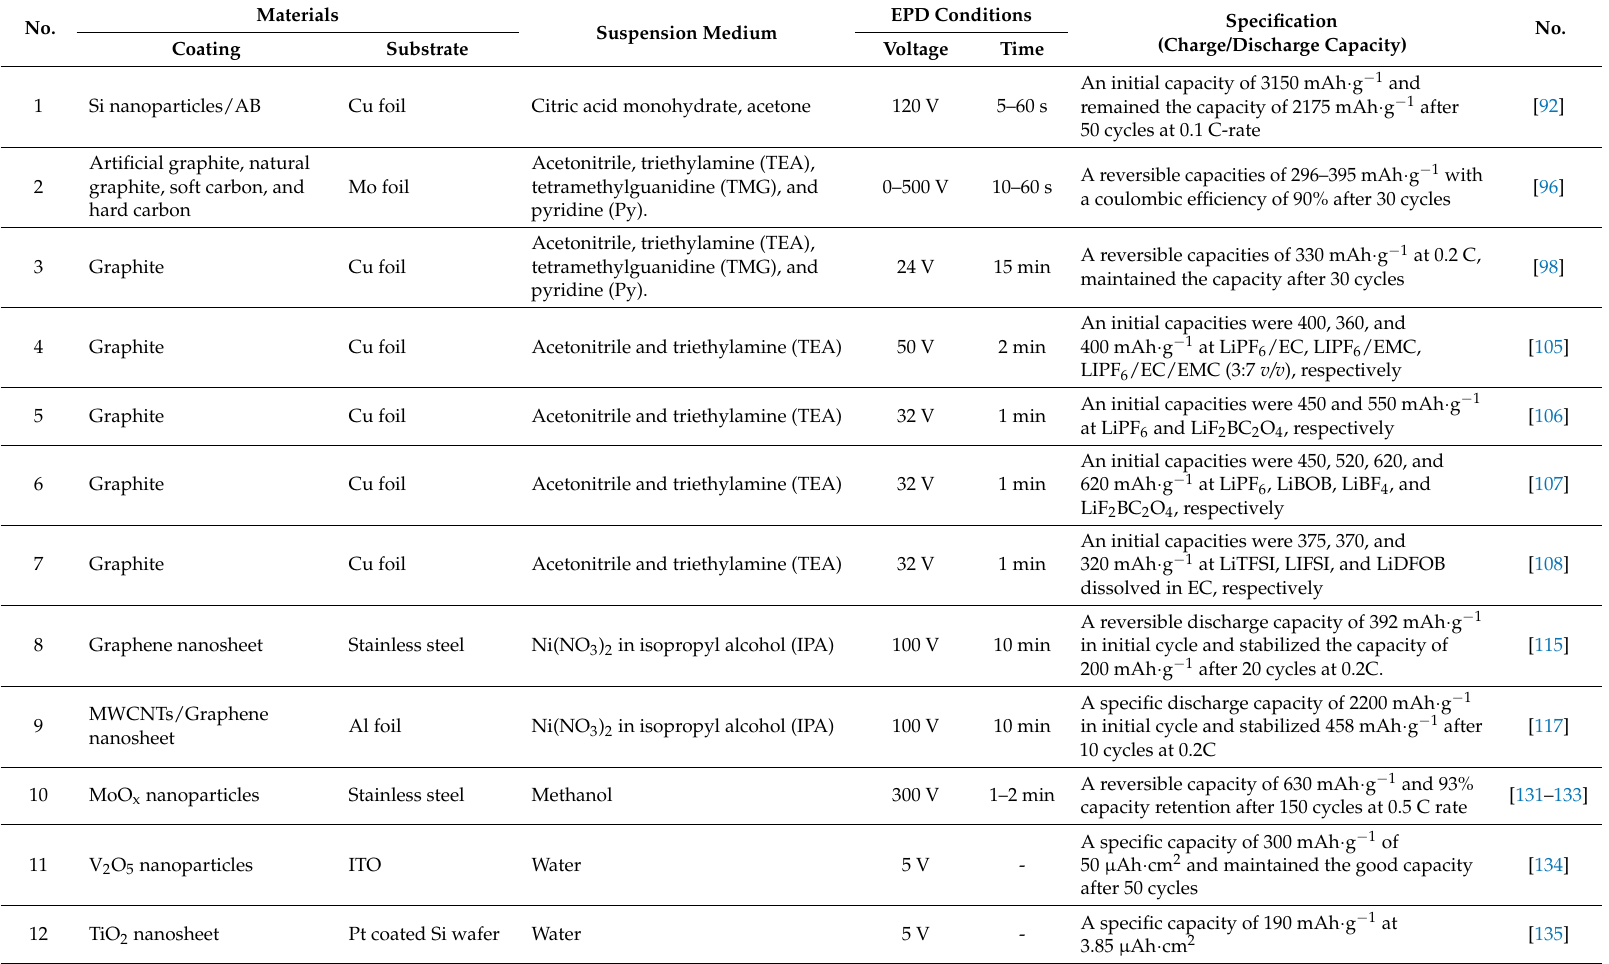
Table A2. Overview of the anode electrodes fabricated by EPD showing the nanomaterials for Li-ion batteries and EPD conditions investigated.